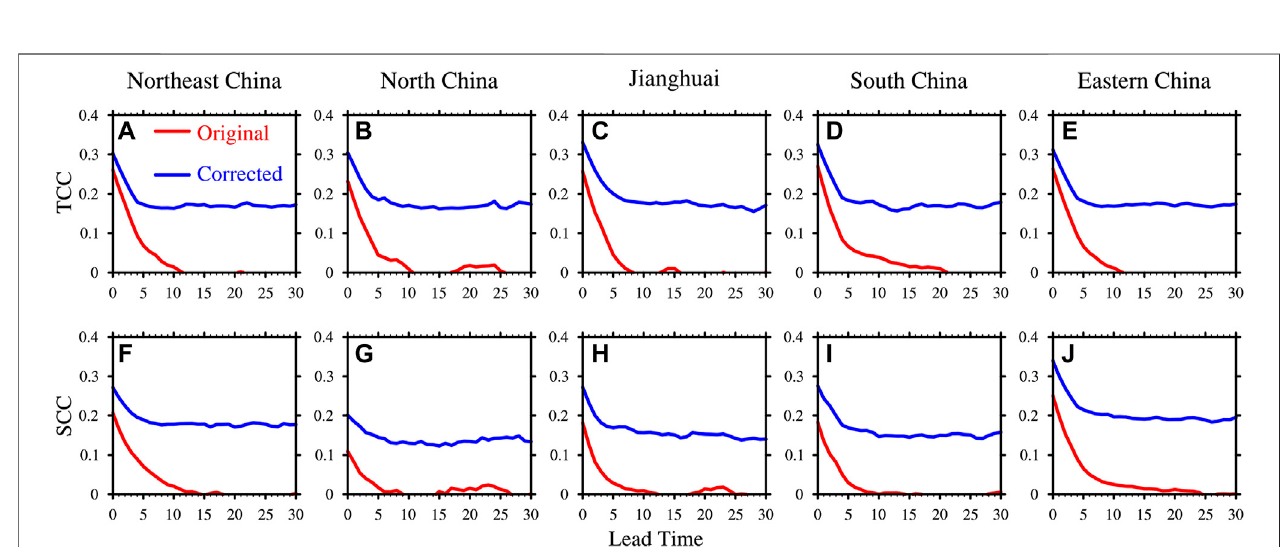
FIGURE 8 | The differences in TCC between the bias corrected predictions and original predictions with different forecast lead time in each region during 1994 – 2013.